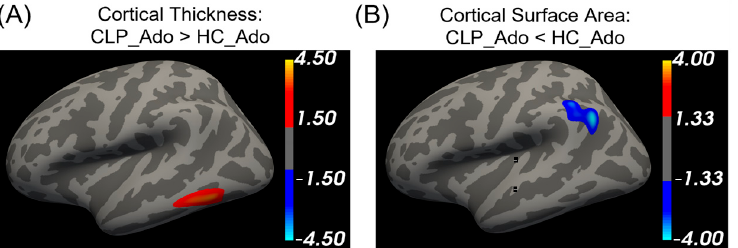
No. cluster = number of clusters, MNI = Montreal Neurological Institute space, Ado = adolescents, Adu = adults. Significance level was set at cluster-wise p < 0.05 with Gaussian random field (GRF) correction. a Independent t -test with age, gender and TIV controlled. b Statistical analysis was conducted using a general linear model. Gender and TIV were controlled as covariances. Significant differences between the group–age slopes were regarded as representing significant interactions between group and age.